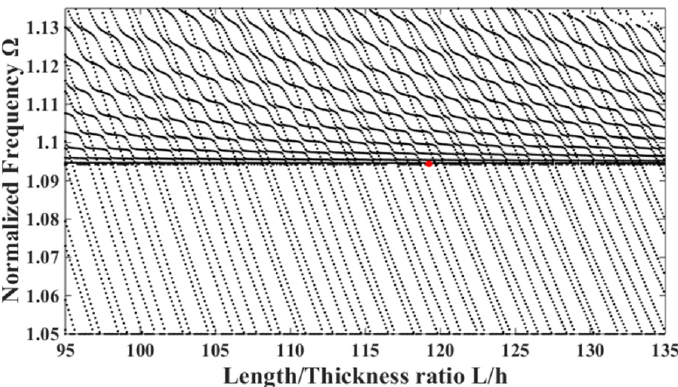
Figure 2. Relationship between the frequency and the ratios of the length to thickness of the LiTaO 3 crystal plate excited by lateral electric fields.